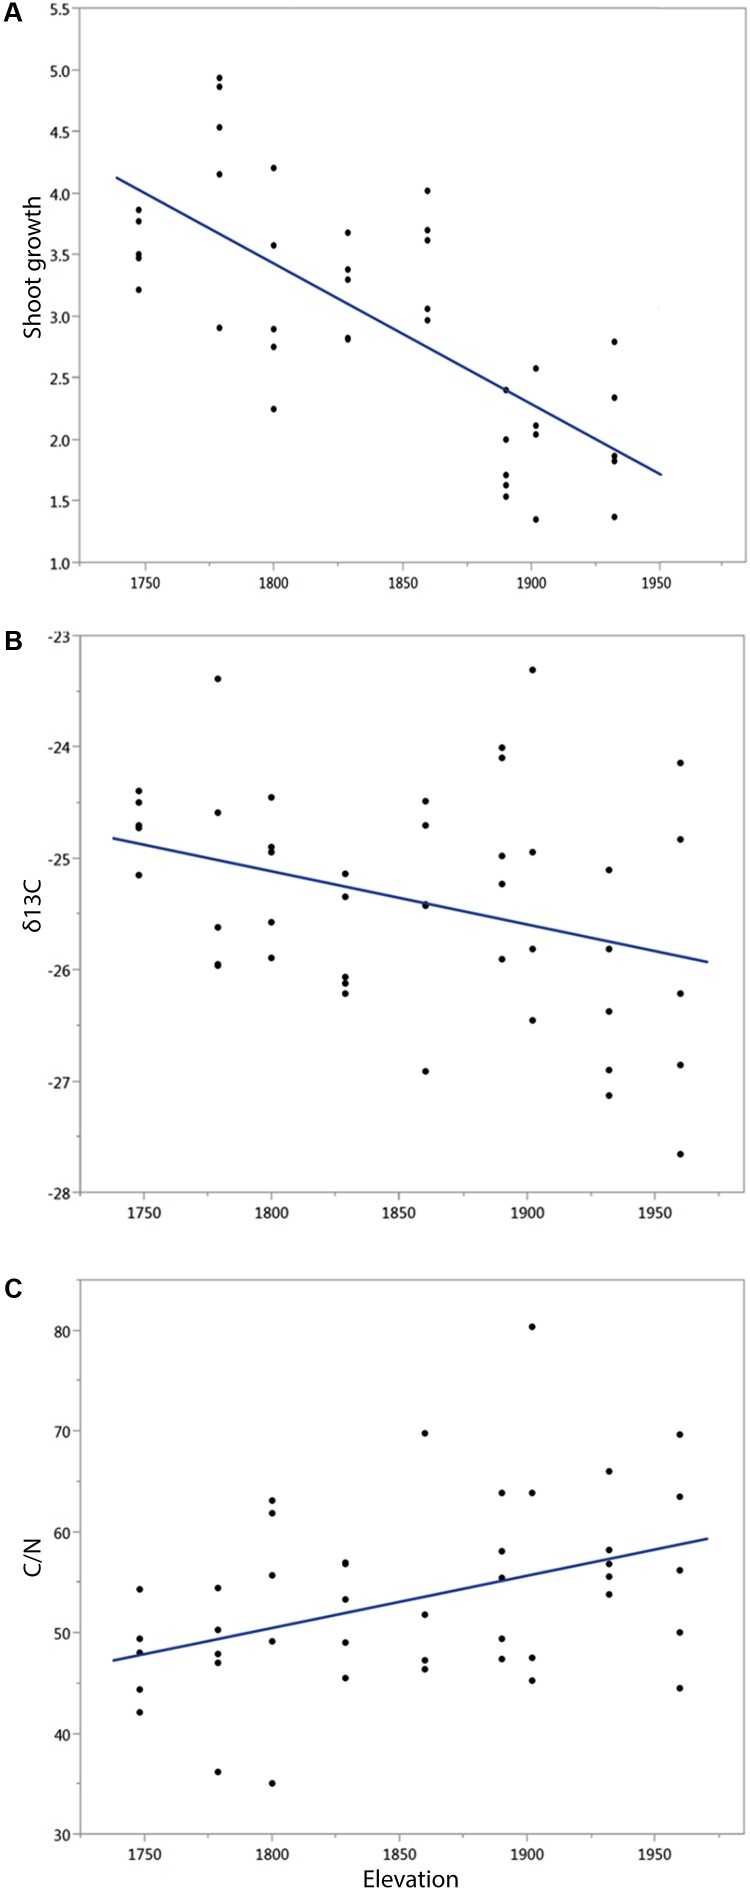
Elevation correlates negatively with (A) average shoot growth (cm) of Pinus edulis and (B) water stress inferred by isotopic δC13 preference. (C) Elevation correlates positively with C:N ratio. Each point represents the data for a single tree.